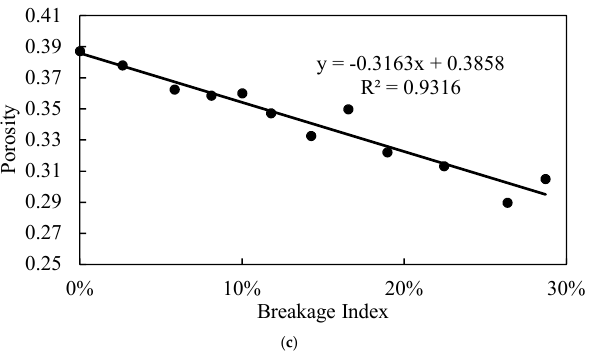
Figure 14. Relationships between breakage index and: ( a ) shear strength; ( b ) co-ordination number; ( c ) porosity.